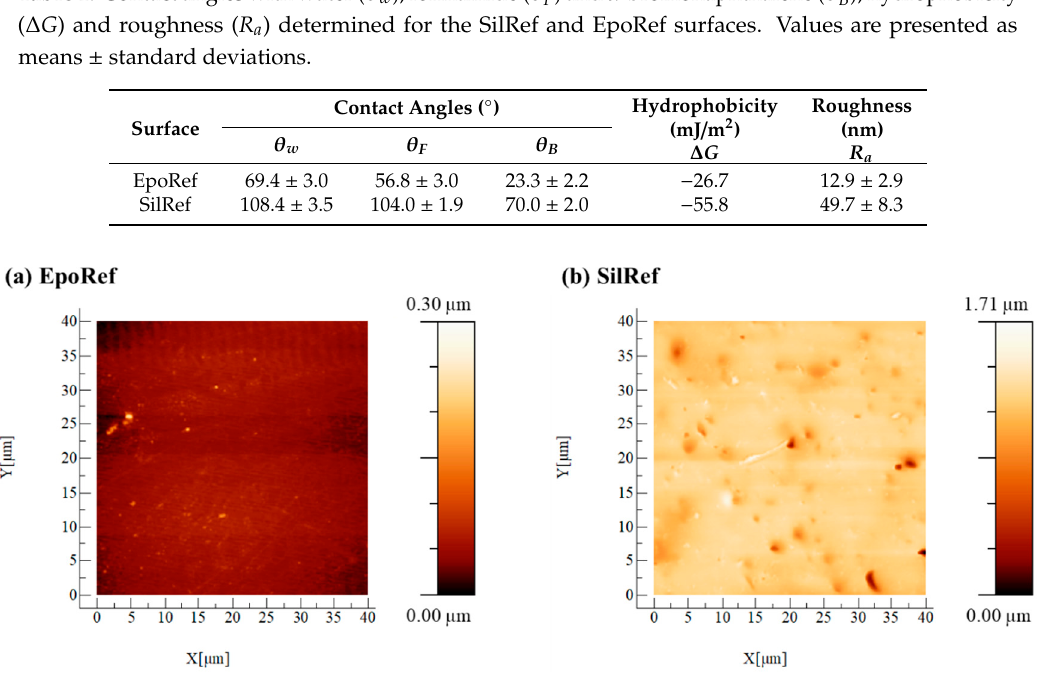
Figure 1. 2D AFM images of EpoRef ( a ) and SilRef ( b ) surfaces with a scan range of 40 µm × 40 µm (contact mode). The color bar corresponds to the z -range of the respective image.